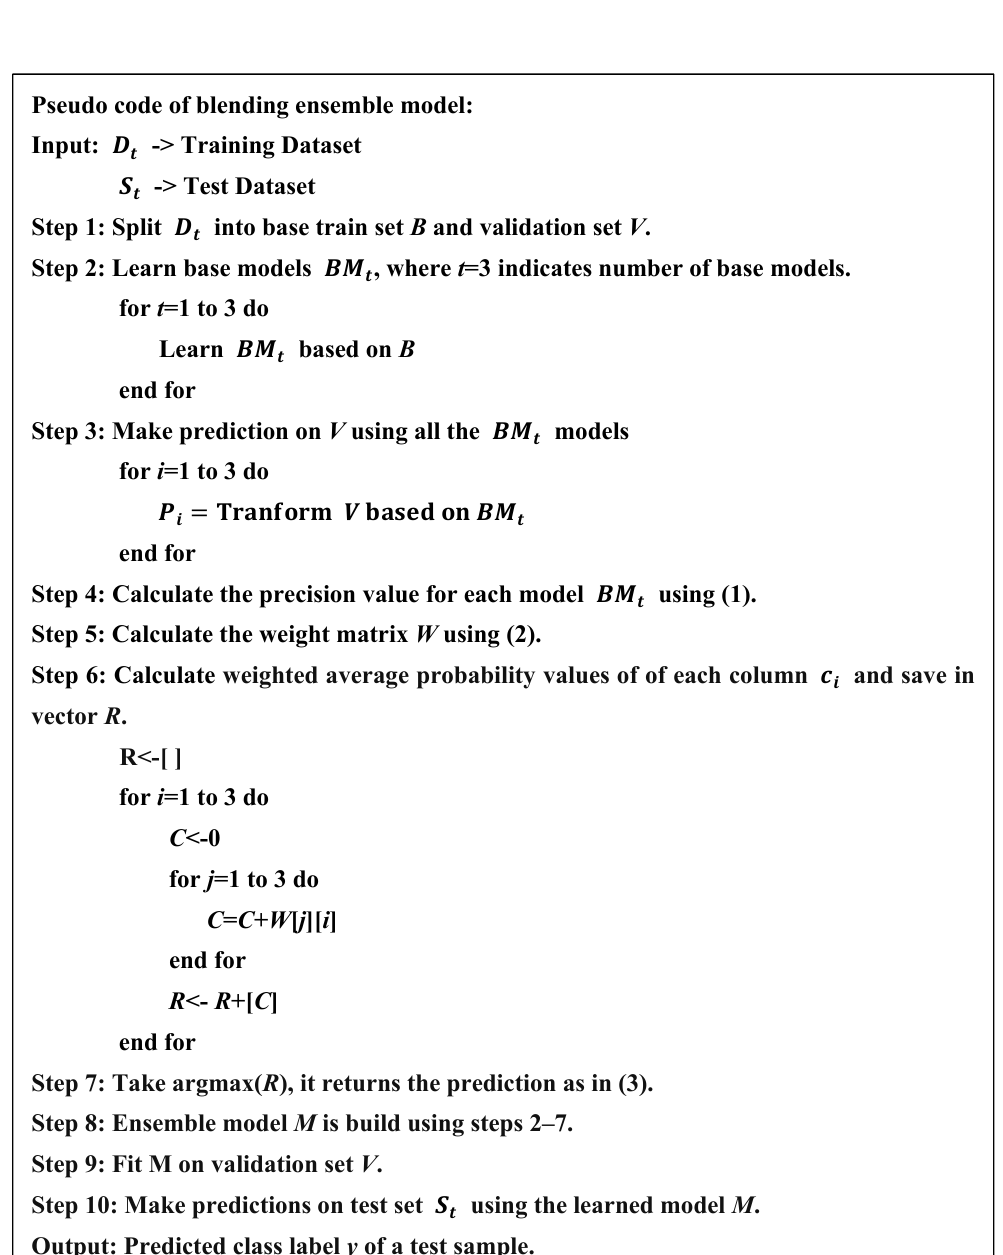
Figure 3. Pseudo code for the proposed ensemble model.